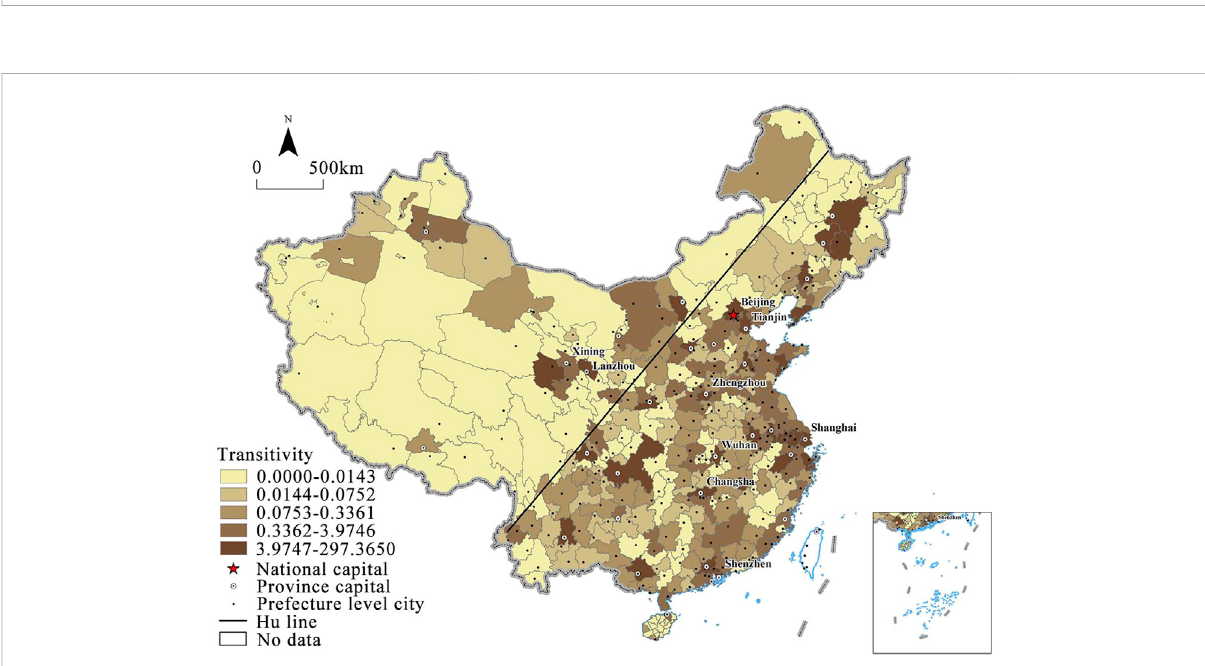
Spatial distribution of the transitivity of China ’ s urban innovation